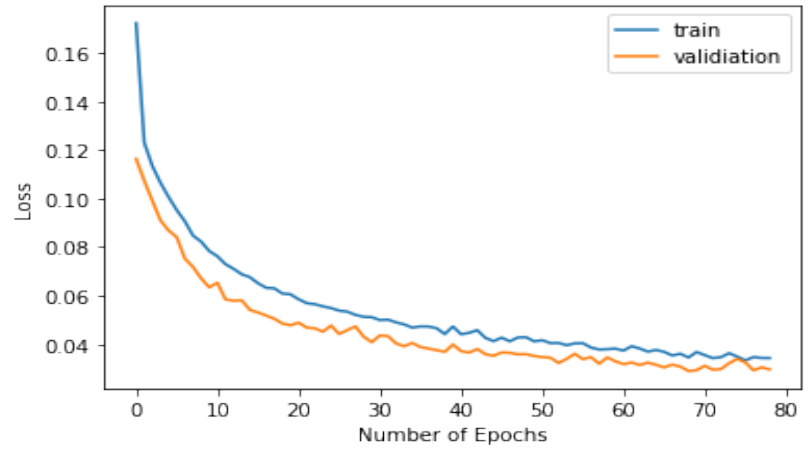
Figure 12. Model loss in training and validation phases in second